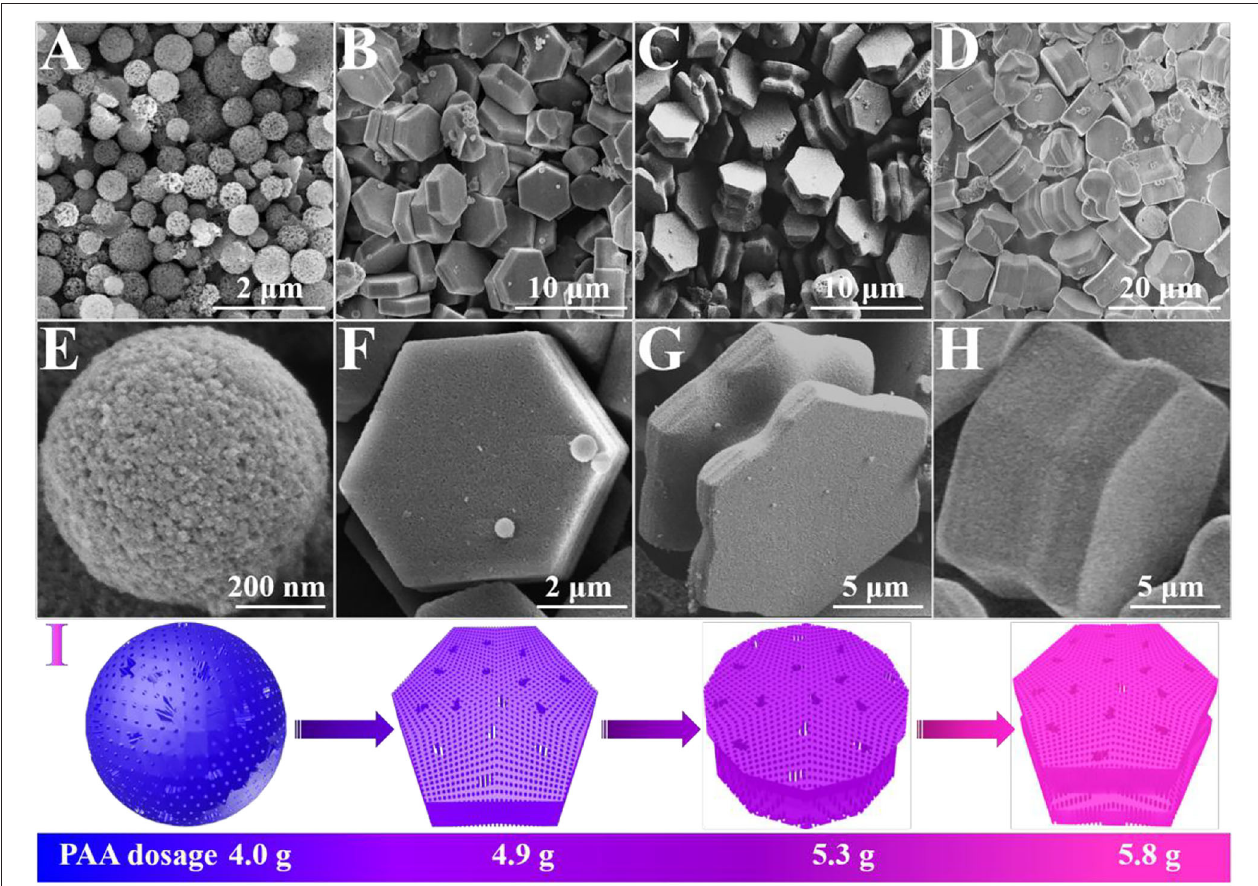
FIGURE 1 | FE-SEM images of the HNCM samples synthesized with different amount of PAA: (A,E) HNCMs-S, (B,F) HNCMs-N, (C,G) HNCMs-D, (D,H) HNCMs-P, and (I) models of morphologies change in these